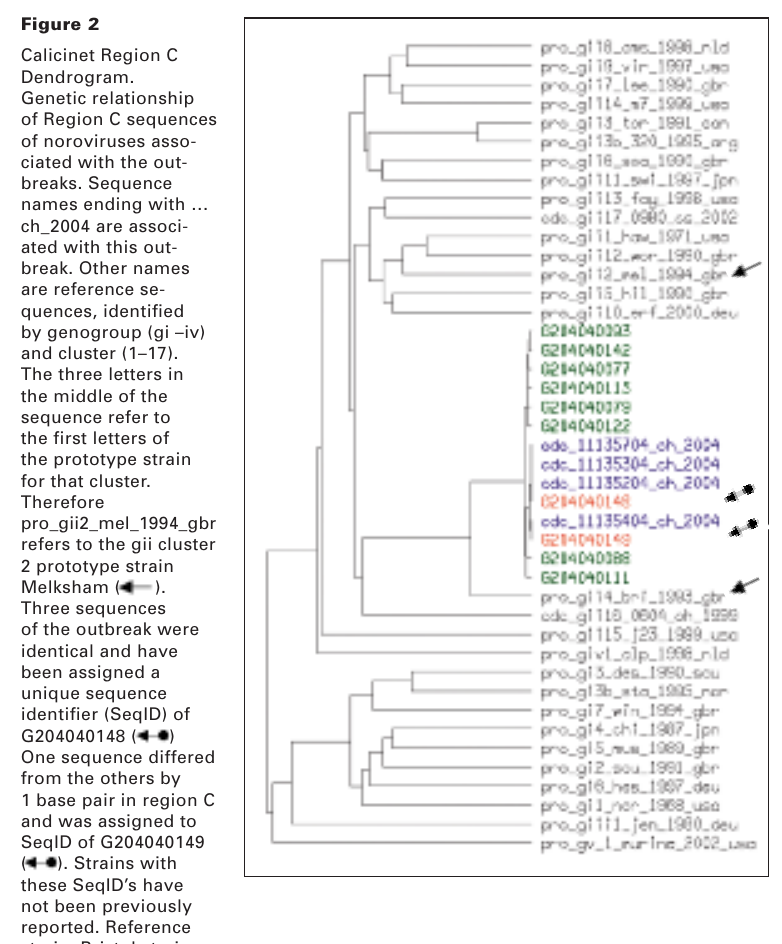
Calicinet Region C Dendrogram. Genetic relationship of Region C